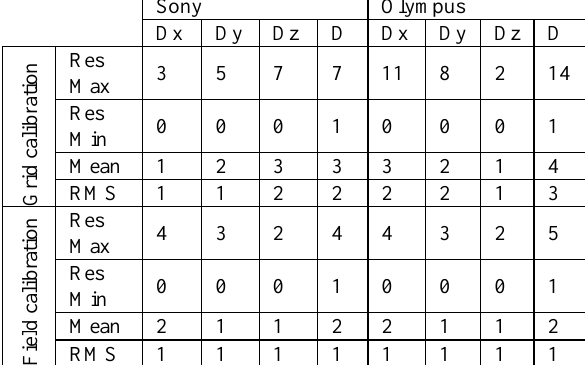
Figure 5. Targets distributed on the façade.